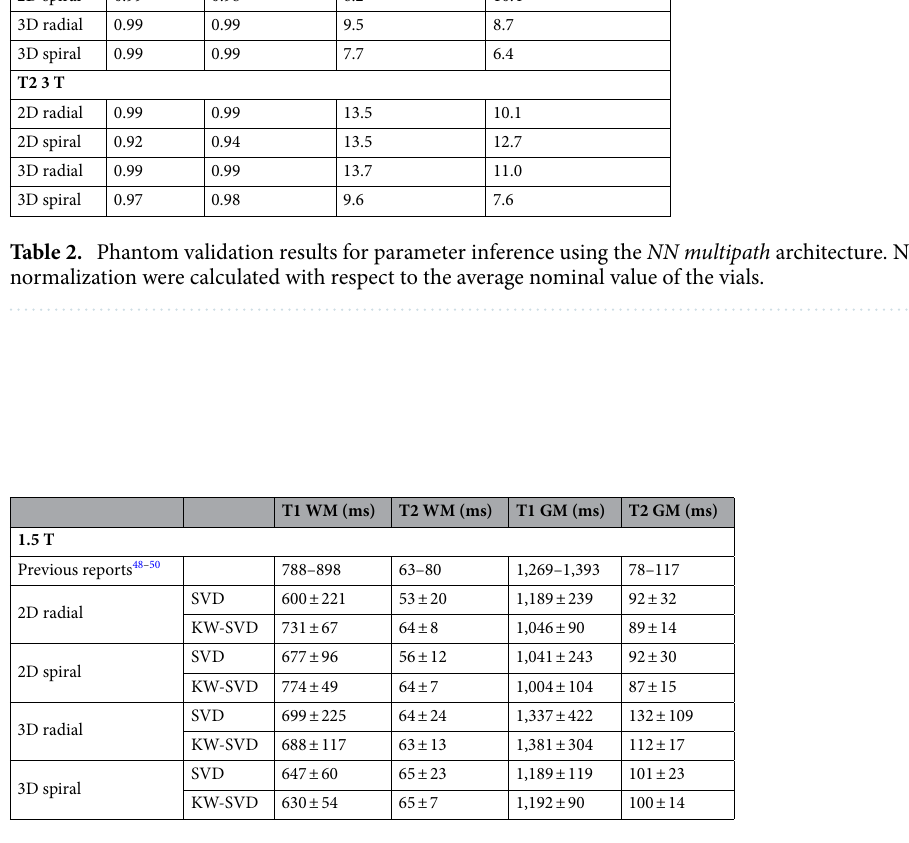
Table 3. In vivo results using the NN multipath architecture. Results for representative ROIs within white matter (WM) and gray matter